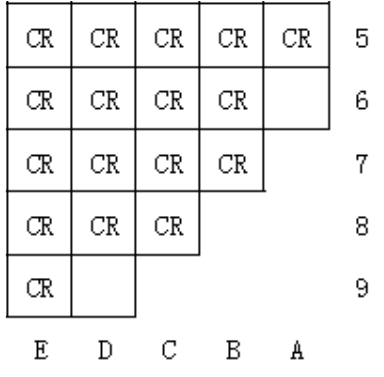
Figure 2. CR Loading Pattern of the Boron-Free Core